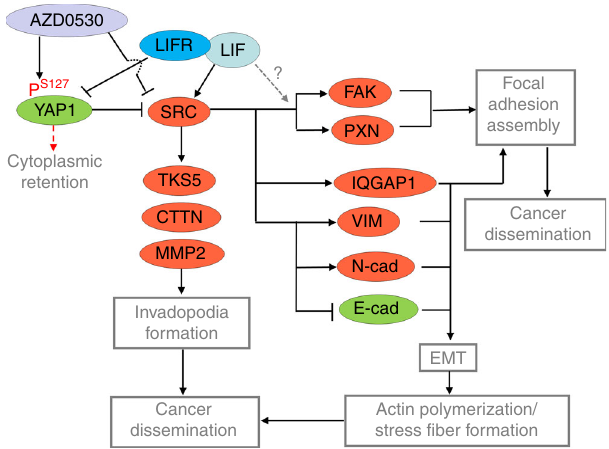
Fig. 9 The schematic model for LIF-mediated cancer dissemination